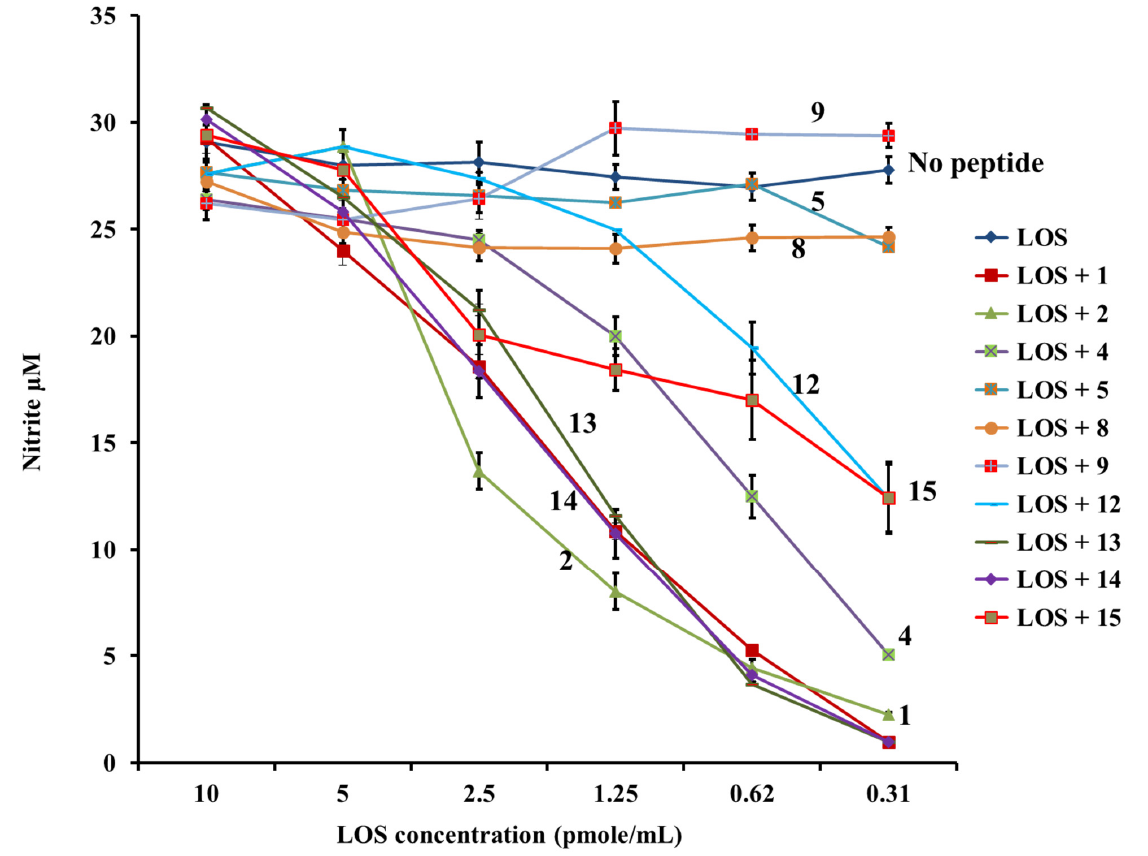
Figure 6. PG-1 analogs neutralized meningococcal LOS bioactivity and inhibited nitric oxide release. Nitric oxide was released from murine RAW264 macrophages induced overnight with meningococcal LOS doses pre-incubated with or without 2 µg/mL of PG-1 or its analogs for 30 min at 37 °C. Nitric oxide release was measured by the Greiss method. Error bars represent ± SD from the mean of duplicate measurements. This experiment is representative of two independent